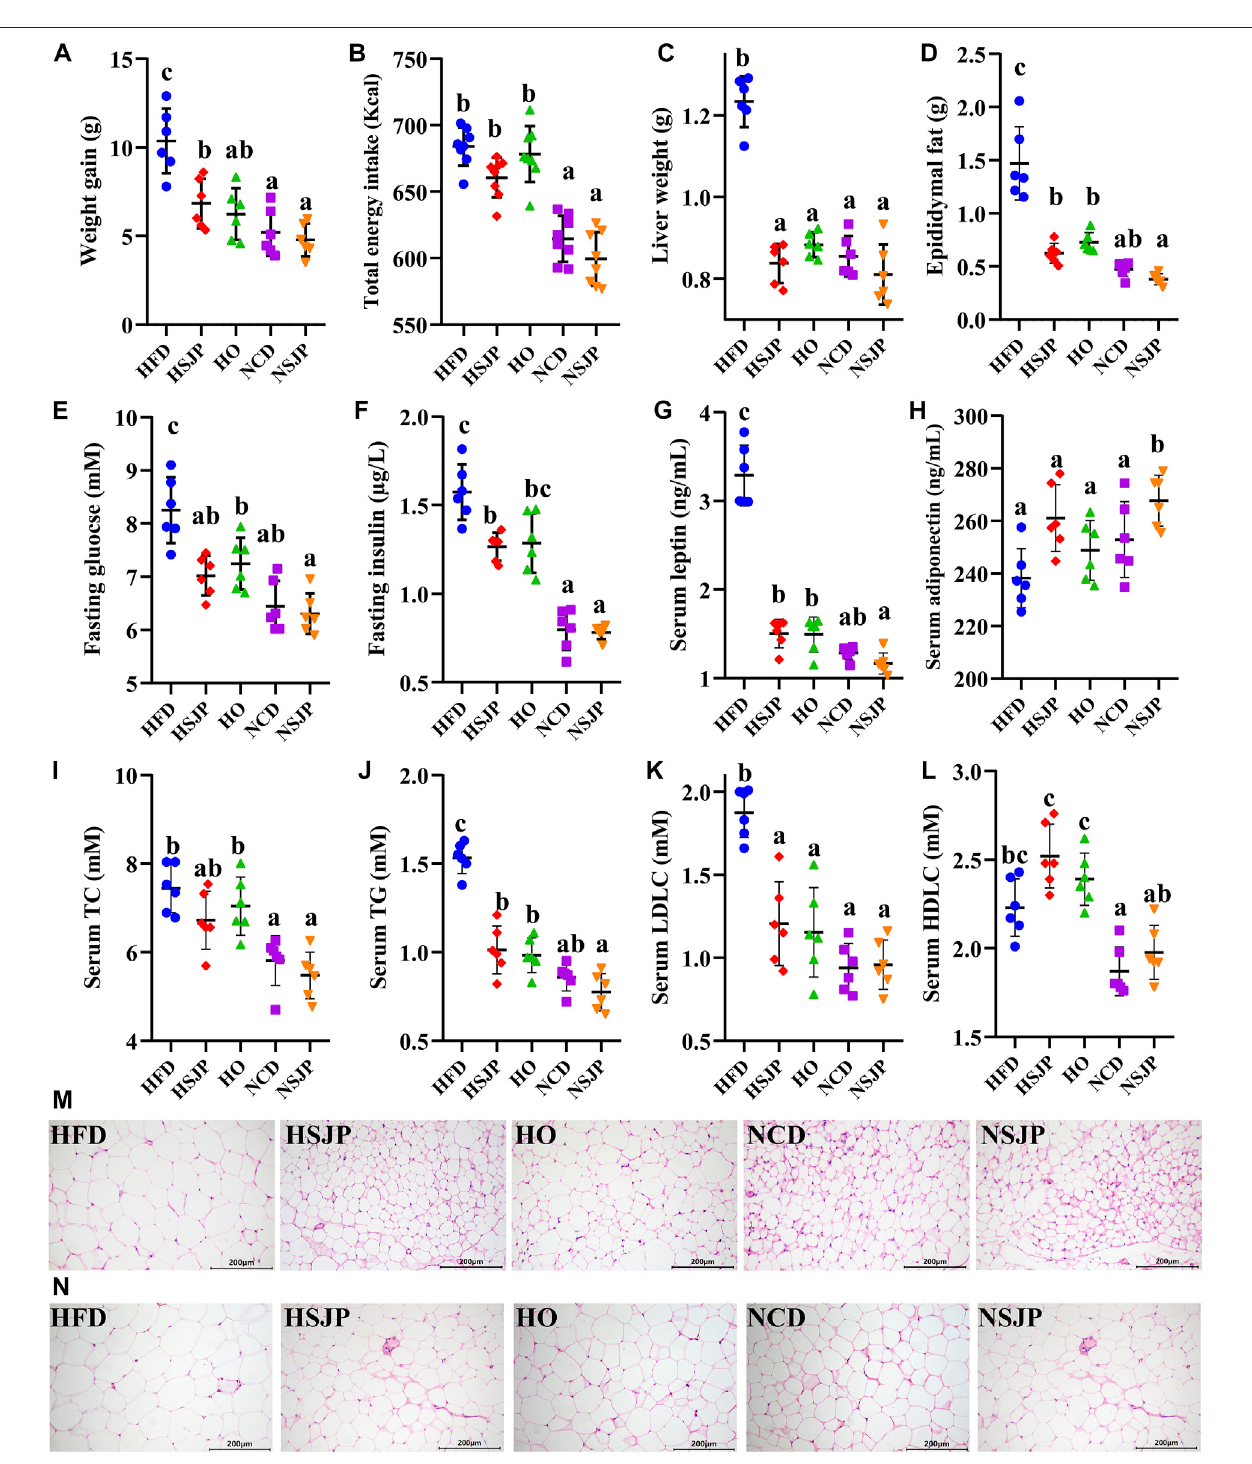
FIGURE 5 | Effects of SJP with respect to preventing HFD-induced weight accumulation and associated metabolic syndromes in mice after 8 weeks of supplementation. (A) Weight accumulation, (B) total daily energy intake in each group, (C) liver weight, (D) epididymal fat weight, (E) level of fasting glucose, (F) fasting serum insulin, (G) leptin, (H) adiponectin, (I) TC, (J) TG, (K) LDLC,and (L) HDLCinserum.RepresentativeH&E-stainedimagesof (M) epididymal and (N) subcutaneous adipocyte (scale bar, 200 mm). Results are shown as mean ± SD ( n (cid:2) 6). a,b,c Signi fi cant differences were analyzed using Kruskal – Wallis with Games – Howell test ( p < 0.05). SJP, seaweed Laminaria japonica polysaccharides; HFD, high-fat diet; TC, total cholesterol; TG, triglycerides; LDLC, low-density lipoprotein cholesterol; HDLC, high-density lipoprotein cholesterol.